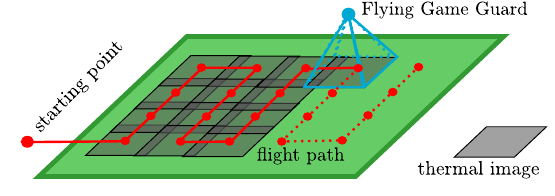
Figure 4: coverage of the